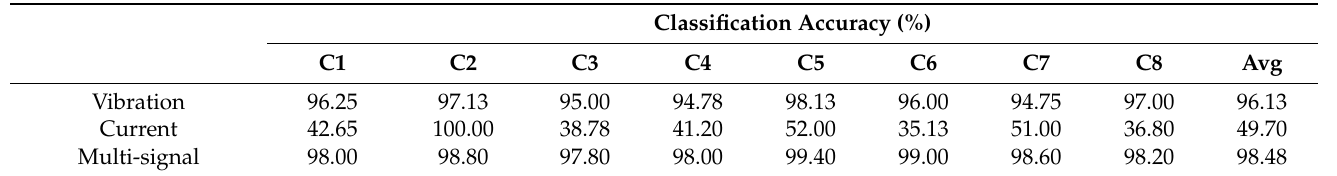
Table 3. DCNN classification accuracy based on single signals and the multi-signal.